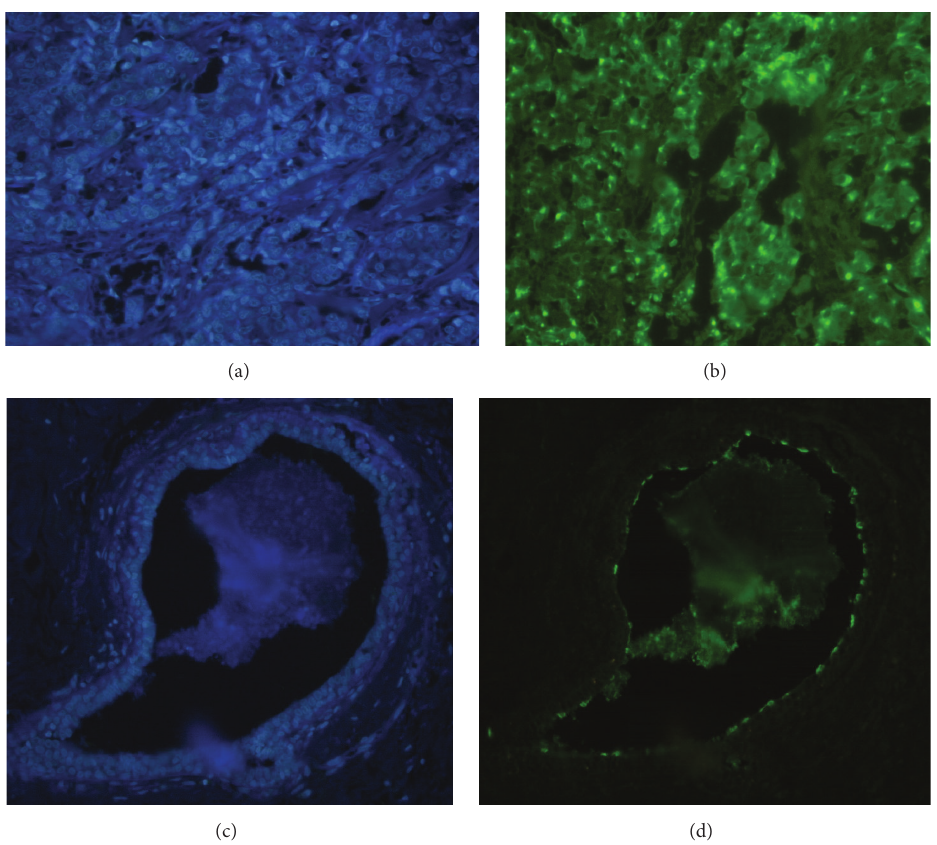
Figure 5: IHC-7E5 1C8 3A10 mAbs against ST3Gal-I (human breast cancer versus human fibroadenoma). (a) DAPI stained human breast cancertissuesection,(b)7E51C83A10mAbsstainedhumanbreastcancertissuesection,(c)DAPIstainedhumanfibroadenomatissuesection, and (d) 7E5 1C8 3A10mAbs stained human fibroadenoma tissue